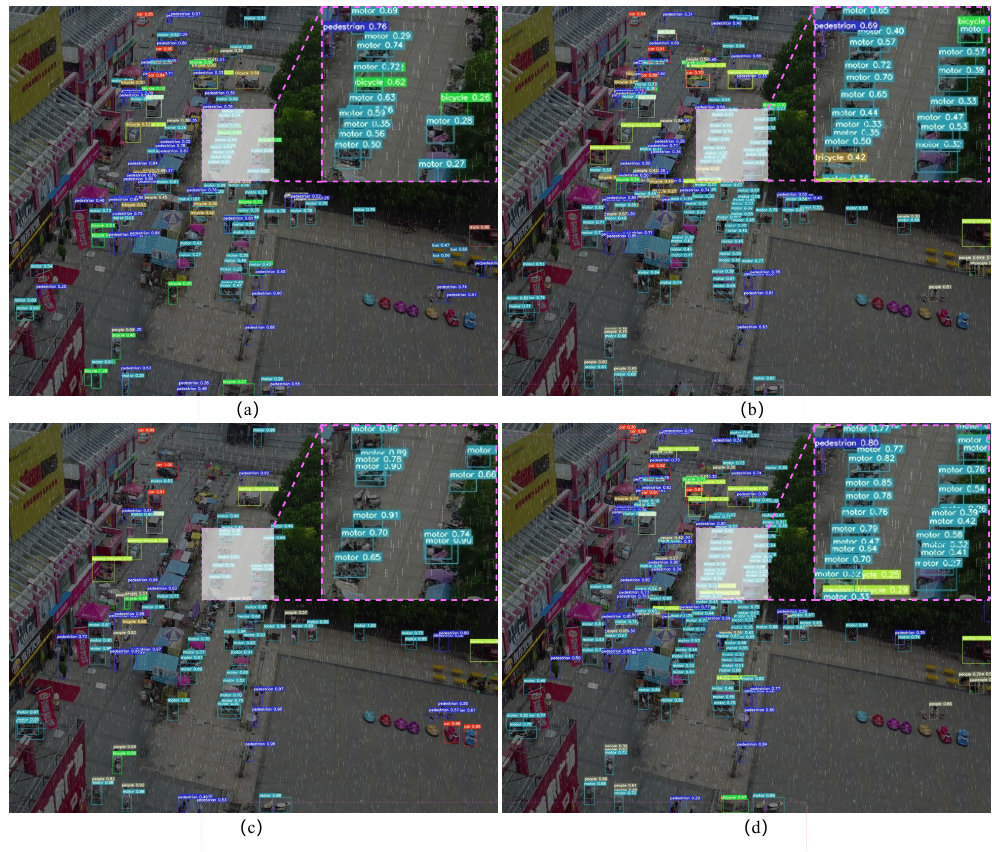
Figure 13. Comparison of the detection results of a medium rainy image taken from the RainVisDrone dataset. ( a ) YOLOv7, ( b ) PReNet-YOLOv7, ( c ) AdaptiveTeacher, and ( d )